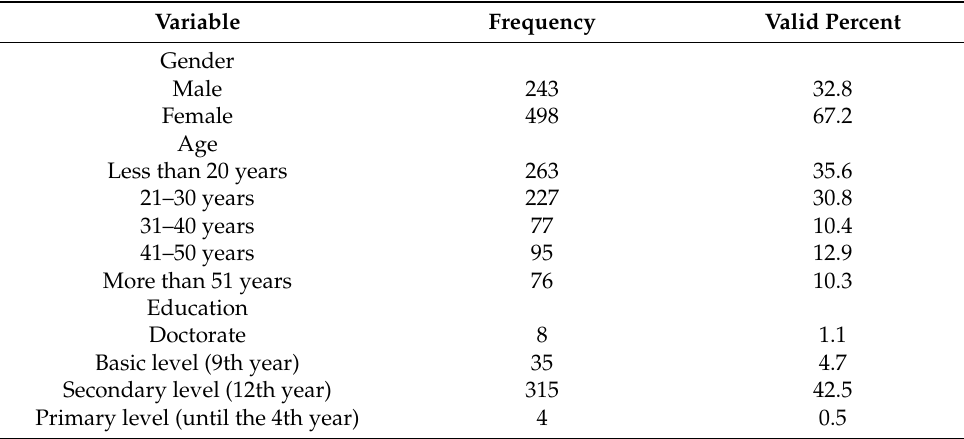
Table 1. Statistics of sociodemographic